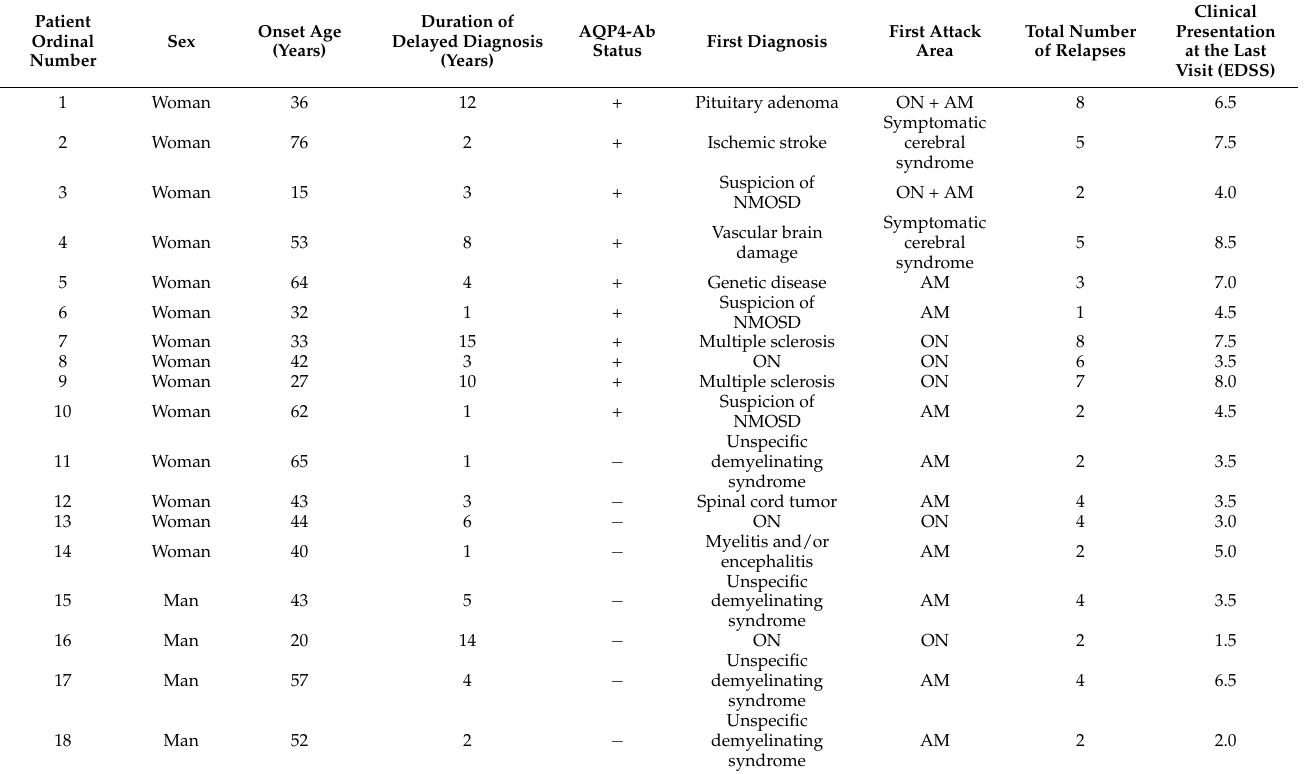
Table 1. Description of the disease course for every patient (end 2014–mid 2018). ON—optic neuritis, AM—acute myelitis, AQP4-Ab—aquaporin-4 antibody, EDSS—expanded disability status scale, NMOSD—neuromyelitis optica spectrum disorder.